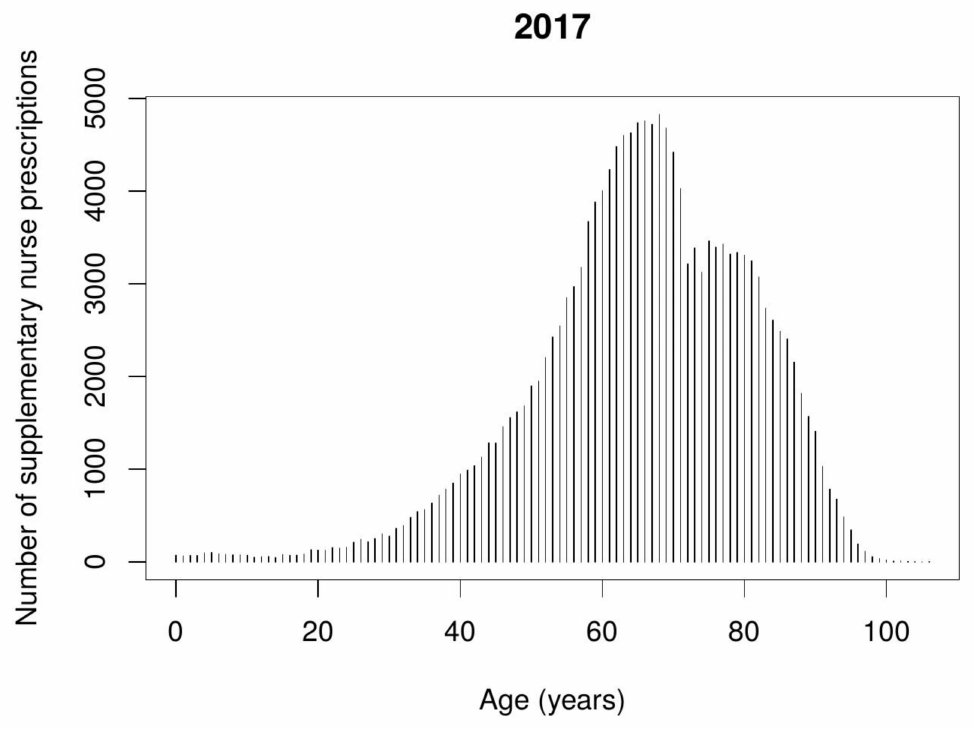
Figure 5. Number of nurse supplementary prescriptions depending on the patient’s age during